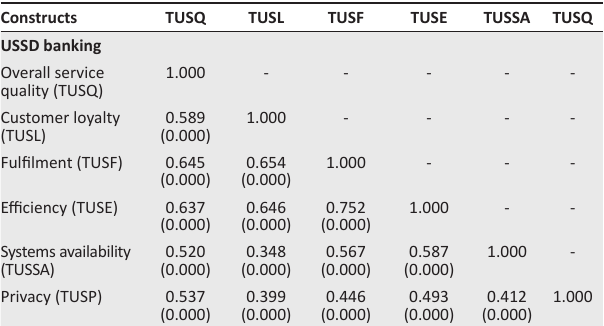
TABLE 3a: Pearson correlation coefficient results of Unstructured Supplementary Service Data banking.